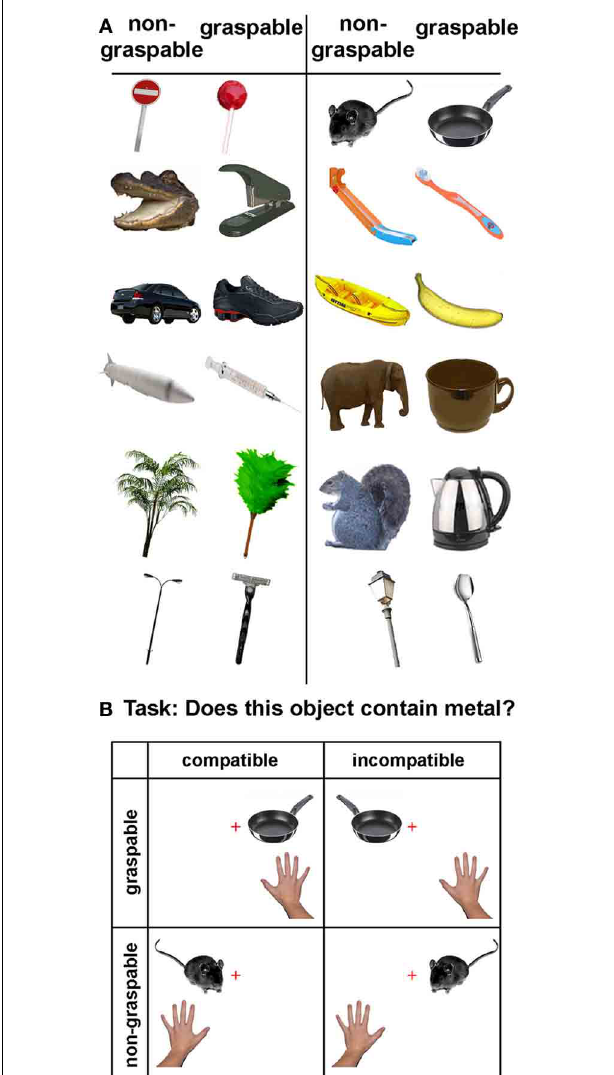
FIGURE 1 | Stimuli and experimental design. (A) The object images used in the experiment. Each graspable object had a non-graspable counterpart, with similar asymmetrical features. Images were projected on a large screen, such that each image was presented near the left or right shoulder of the participants. (B) Experimental design. A 2 × 2 factorial design was used, with factors: graspability (graspable, non-graspable), and spatial compatibility (compatible, incompatible). The resulting four trial types are demonstrated, using one pair of objects. The hand illustrates the limb that will result in a correct response, and the cross illustrates the fixation point (in this example, subjects were asked to respond to metal objects with their right arm). Stimulus-response mapping was counterbalanced between